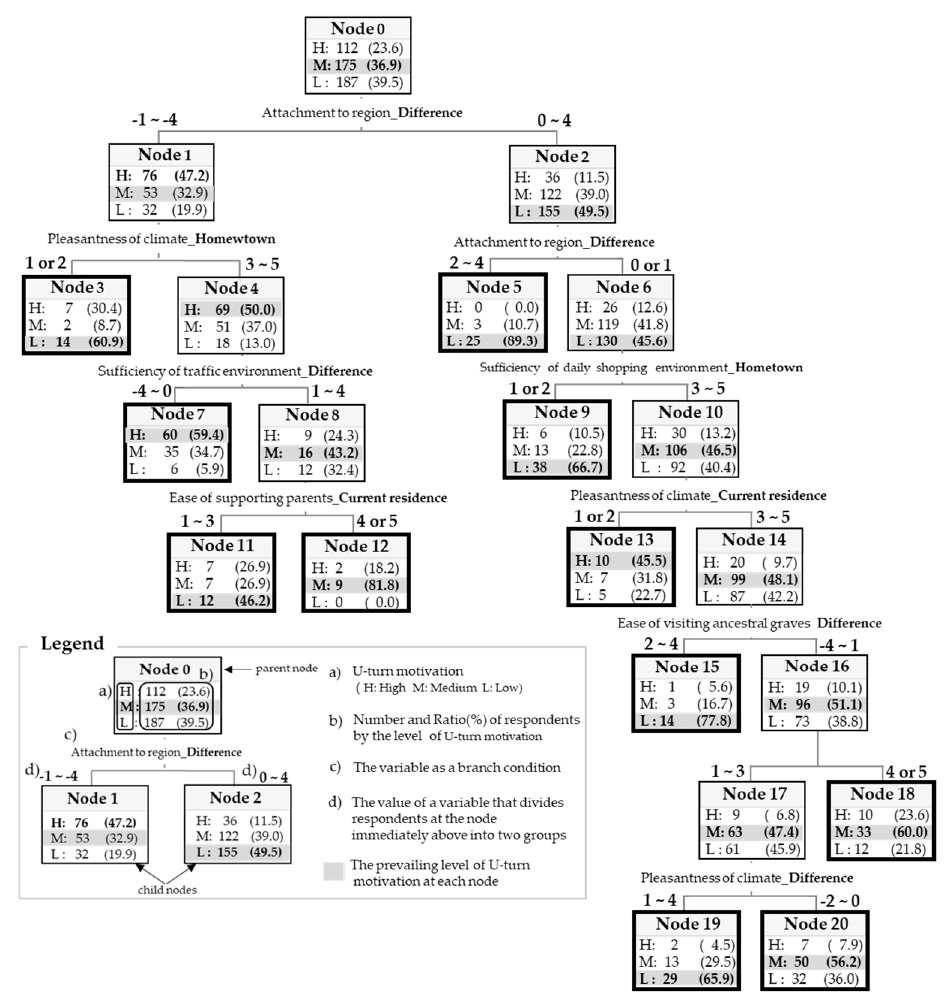
Figure 3. The results of the decision tree analysis, showing eleven nodes (bold-lined boxes) representing significant categories. Table 5. The summaries of branch conditions and their rankings at each last node.